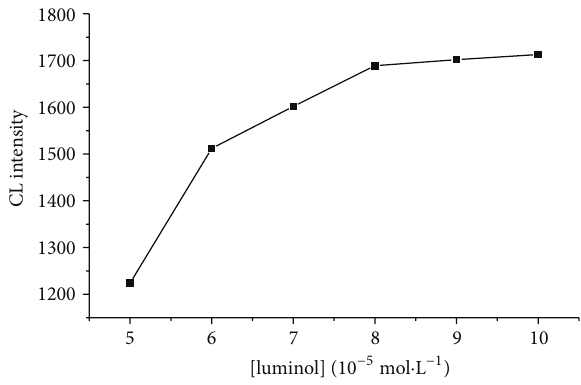
Figure 4: Effect of luminol concentration on CL intensity. Condi- tion: [ENRO] = 2.0 × 10 −6 g ⋅ L −1 , [K 3 Fe(CN) 6 ] = 4.0 × 10 −4 mol ⋅ L −1 , luminol in 0.2 mol ⋅ L −1 NaOH solution. Table 1: Determination results of ENRO in